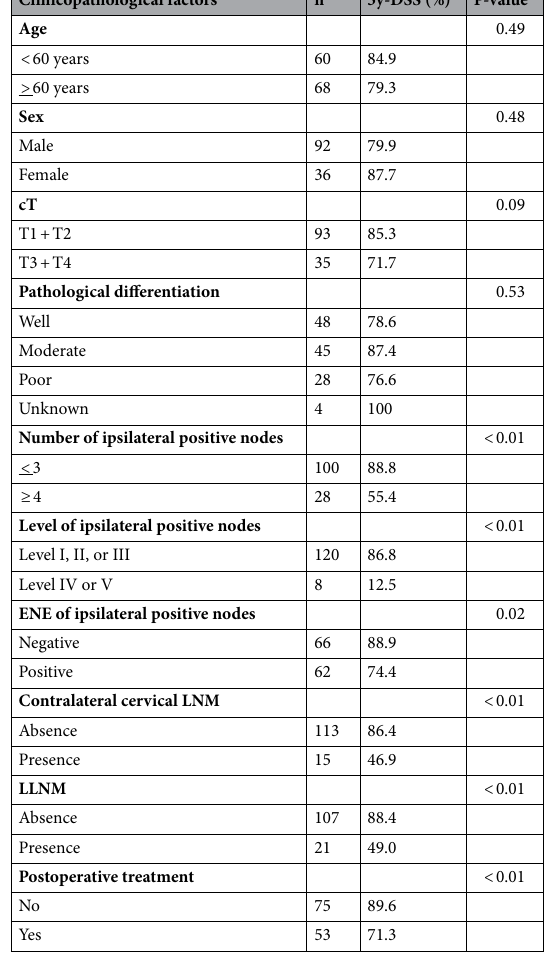
Table 2. Univariate analyses of factors related to 5-year disease-specific survival in tongue SCC patients with lymph node metastases. SCC squamous cell carcinoma, 5y-DSS 5-year disease-specific survival, LNM lymph